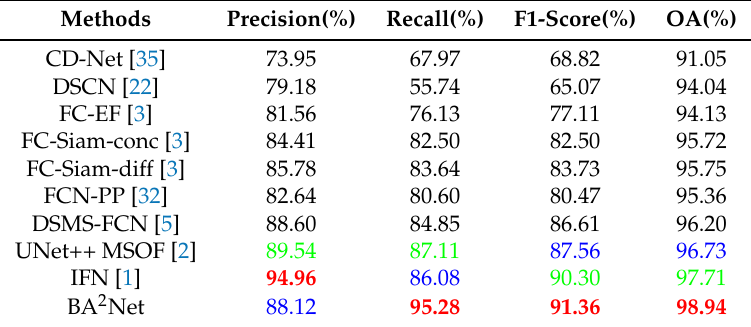
Table 4. Quantitative results on LEBEDEV of BA 2 Net and other SOTA methods.